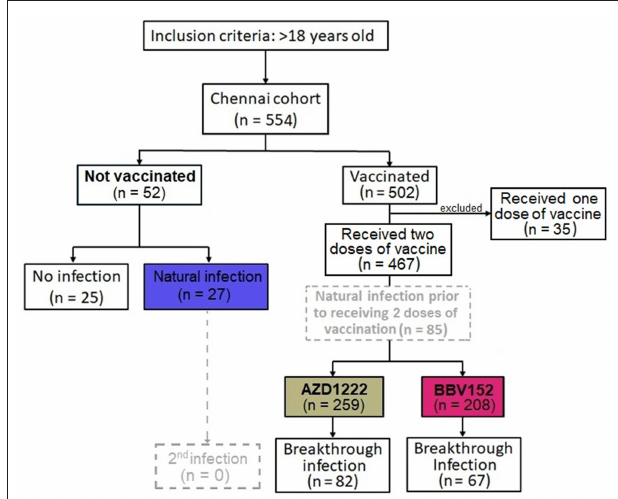
FIGURE 1 | Flow diagram of 519 participants recruited into the Chennai (India) Cohort from March to December 2021. Based on the sequence of natural infection and type of vaccine administered, the cohort is divided into four groups viz., (i) No vaccination, no natural infection, (ii) no vaccination, with natural infection, (iii) vaccination with AZD1222 and (iv) with BBV152. Of note, a small fraction of vaccine recipients had a documented history of natural infection prior to receipt of the corresponding vaccine ( n = 85); whilst another group of participants developed a breakthrough infection 14 days post-vaccination ( n = 149). The colored boxes, present three main patient groups in the investigation.